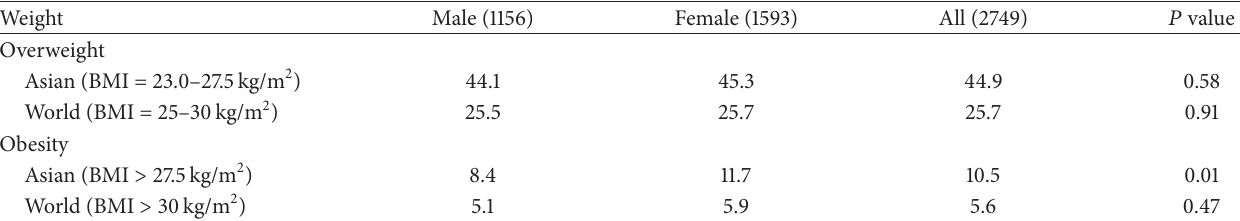
Table 3: Gender distribution of overweight and obesity of rural cohort for assessment of cardiovascular diseases (CVDs) risk factors in sub-Himalayan region of India, 2011.